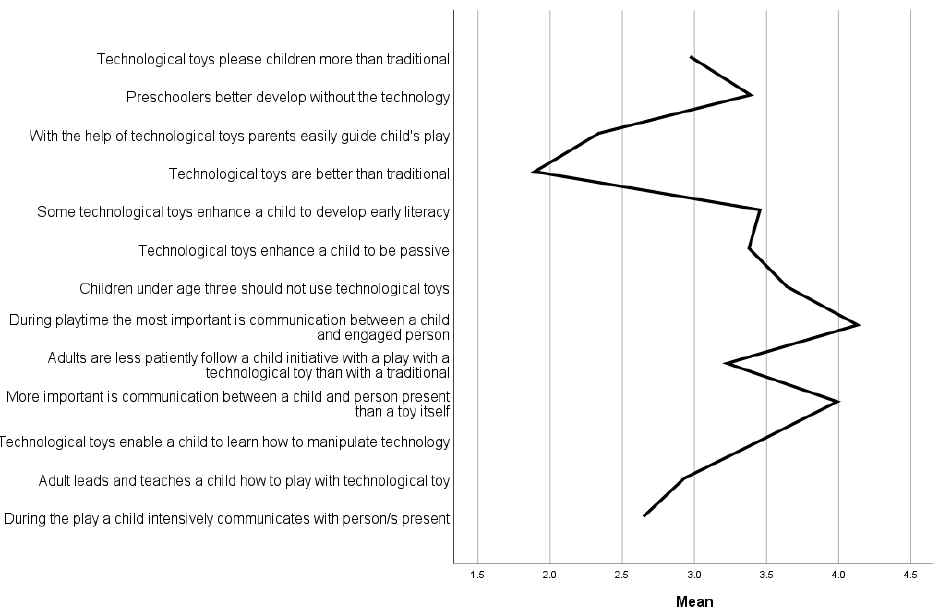
Figure 3. Parents perceive characteristics of child’s play with traditional and digital toys.